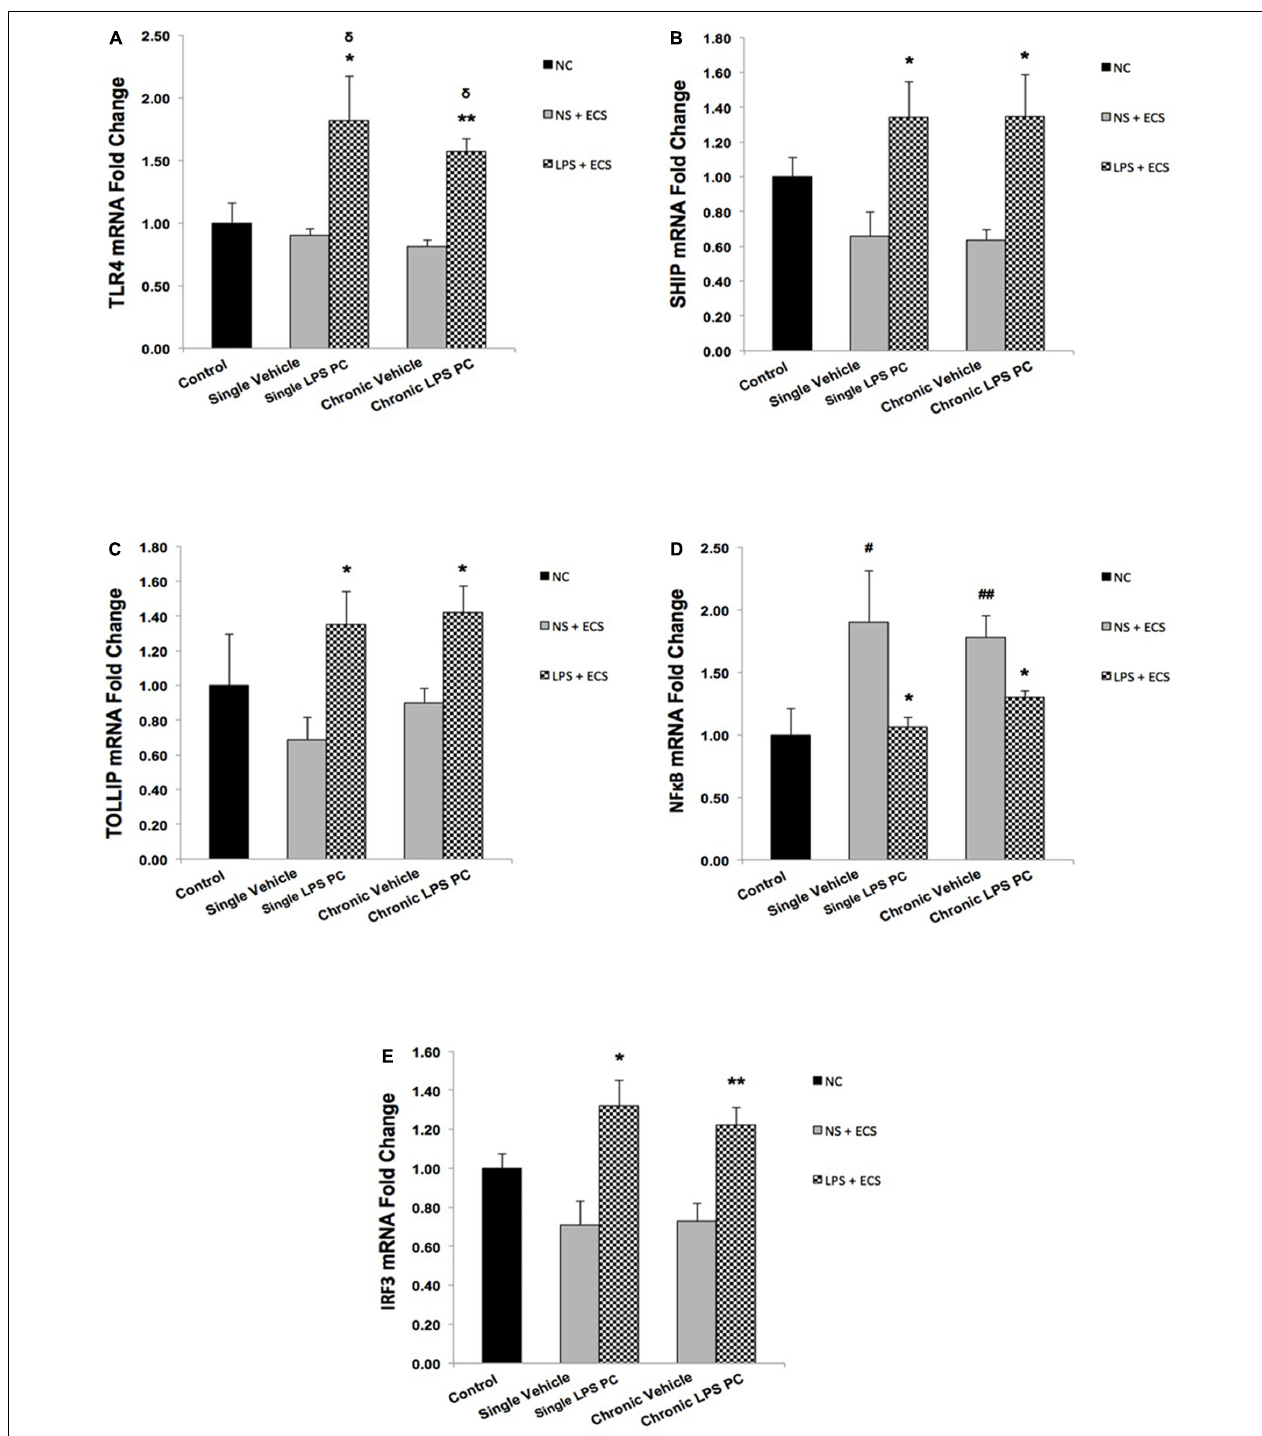
FIGURE 6 | Expression level of genes related to TLR4 signaling pathway in the hippocampus region of rat brain in the ECS model of epilepsy. The graphs above display the effect of PC by single low dose and chronic ultra-low dose of LPS on the gene expression level of (A) TLR4, (B) SHIP1, (C) TOLLIP, (D) NF κ B, and (E) IRF3 in hippocampus in control, single preconditioned, and chronic preconditioned groups. Asterisk ( ∗ ) denotes a significant difference between the preconditioned groups and vehicle groups. Delta ( δ ) denotes a significant difference between the preconditioned groups and control groups. Hash (#) denotes a significant difference between the vehicle groups and control groups. Statistical analysis has been done according to the one-way ANOVA with significance levels of ∗ ρ < 0.05; ∗∗ ρ < 0.01; δ ρ < 0.05; # ρ < 0.05; and ## ρ < 0.01. Data are shown as mean ± SEM of three animals ( n = 3), which expressed as fold change relative to control group. ECS, electroconvulsive shock; NS, normal saline; LPS, lipopolysaccharide; PC, preconditioning; NC, no current was passed through the electrodes.